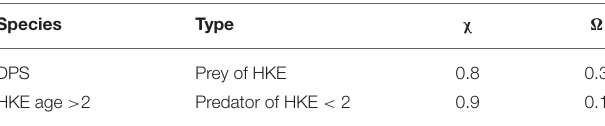
TABLE 3 | Parameters of the trophic relationships considered into the MICE model.